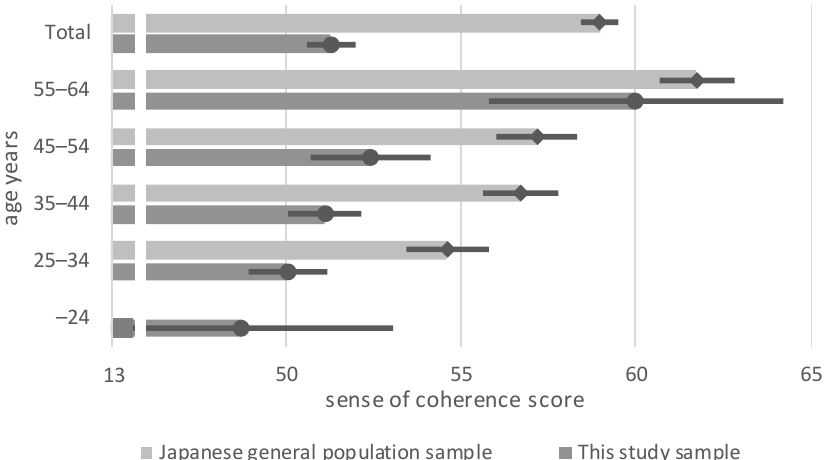
Figure A1. Comparison of the sense of coherence scores between the sample of this study and the Japanese general population sample by age group. Note. Error bars are 95% confidential interval.